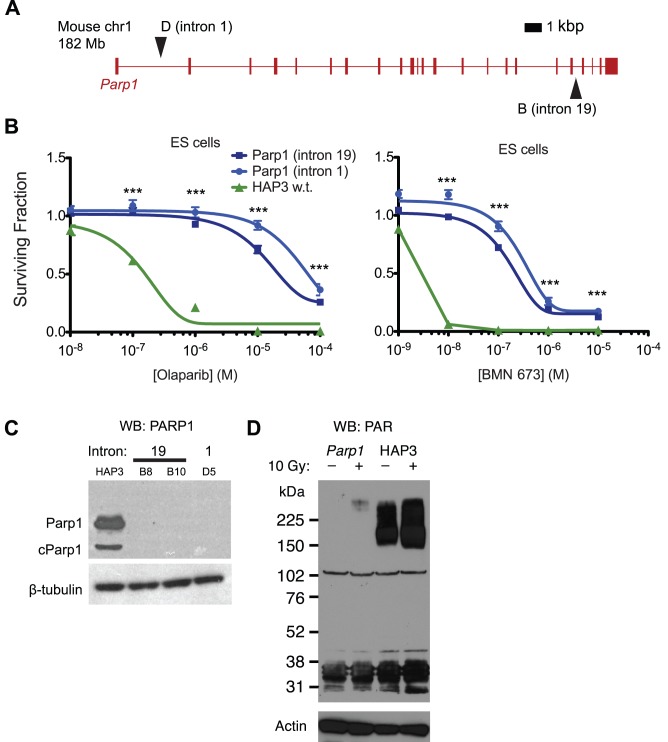

Parp1 null mutants are resistant to PARP inhibitors.
A. Positions of insertions in the Parp1 gene in resistant mutants. B. Olaparib and BMN 673 dose-response curves for Parp1 mutants (blue) and wild type HAP-3 cells (green). Surviving fraction is assessed using CellTiterGlo and normalised to DMSO-treated control cells. The mean of five replicates is shown; error bars show SEM. ***, P<0.001 for intron one mutant (D) compared to HAP-3. C. The Parp1 mutations are null alleles. Lysates from the indicated cells were probed with anti-PARP or anti-β-tubulin antibodies. A lower molecular weight band corresponding to cleaved Parp1 is also detected in wild type cells at the long film exposure used here. Similar results were obtained using a different antibody and independently prepared lysates (see Figure 5A). D. Low PAR levels and decreased induction of PAR in response to ionising radiation in Parp1 mutant ES cells. Data shown are representative of three experiments, using multiple Parp1 mutant subclones and wild type cell lines.